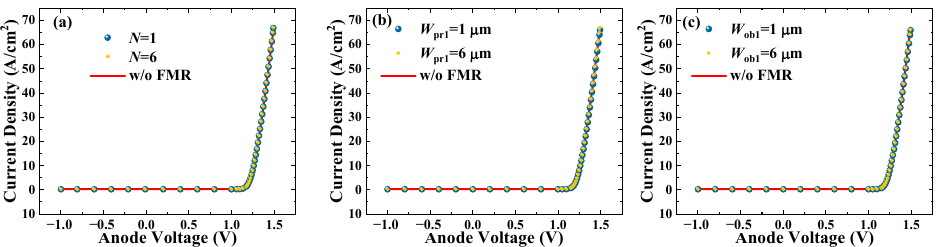
Figure 3. Forward voltage–current characteristics of SBD: ( a ) with different numbers of FMR, ( b , c ) with single FMR, ( b ) with different ring spacing, and ( c ) with different ring widths.